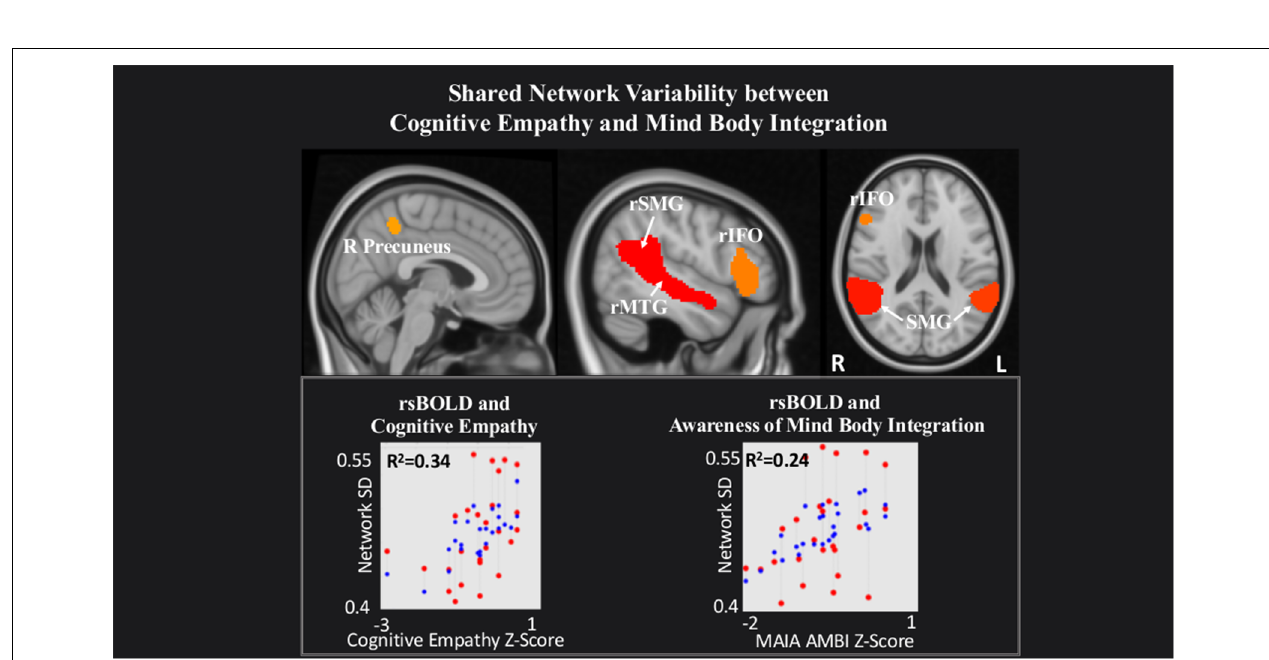
FIGURE 4 | Shared network variability between Cognitive empathy and MAIA Mind-Body Integration statistical maps are FDR-corrected within the network at cluster-based p < 0.05, after the voxel threshold at p < 0.001, and further corrected for age, gender, and multiple comparisons across components using FDR. Note: the red dots in the graph represent the observed correlation between the standard deviation of the individual network’s BOLD time-series (SD BOLD ) and each subjects’ behavioral measure. The blue dots represent the predicted values of the statistical model. The R 2 value represents the variance explained resulting from the regression between SD BOLD and behavioral variables of